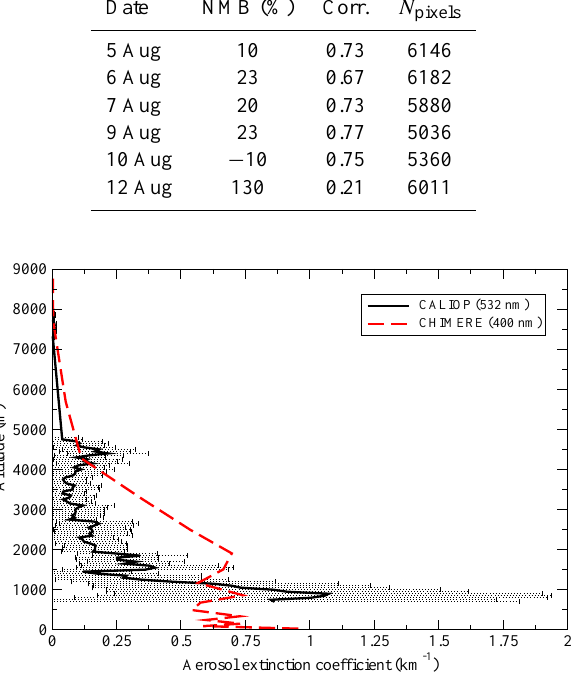
Fig. 2. Vertical profile of the aerosol extinction coefficient (in km − 1 ) retrieved by CALIOP (at 532nm) and modelled by CHIMERE (at 400nm) during 9 August at midnight in the north of Moscow (59.9 o N, 37.6 o E) located within the aerosol plume (see figure 1). Uncertainty on CALIOP measurements are indicated by error bars. Fig. 1b. Geographic distribution of the AOT over eastern Europe from 5 to 12 August 2010 observed by the POLDER satellite sensor (at 550nm) and modelled by CHIMERE (at 400nm). The location of CALIOP measurements analysed in this study is indicated.